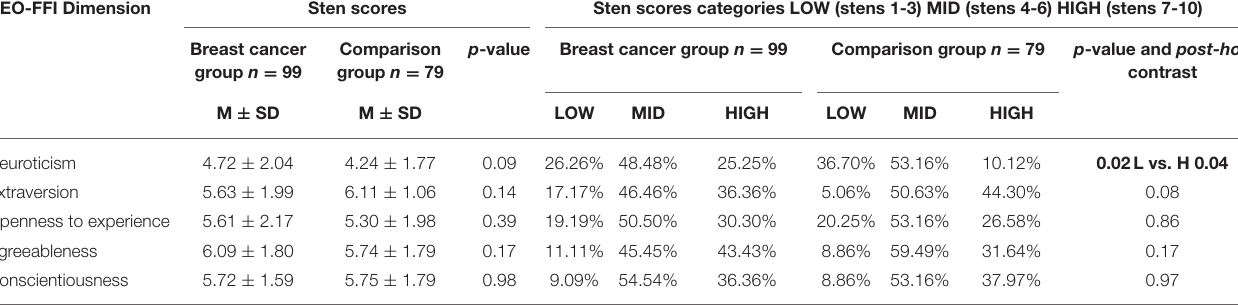
TABLE 2 | Scores on the big five personality model for the breast cancer and control groups. NEO-FFI Dimension